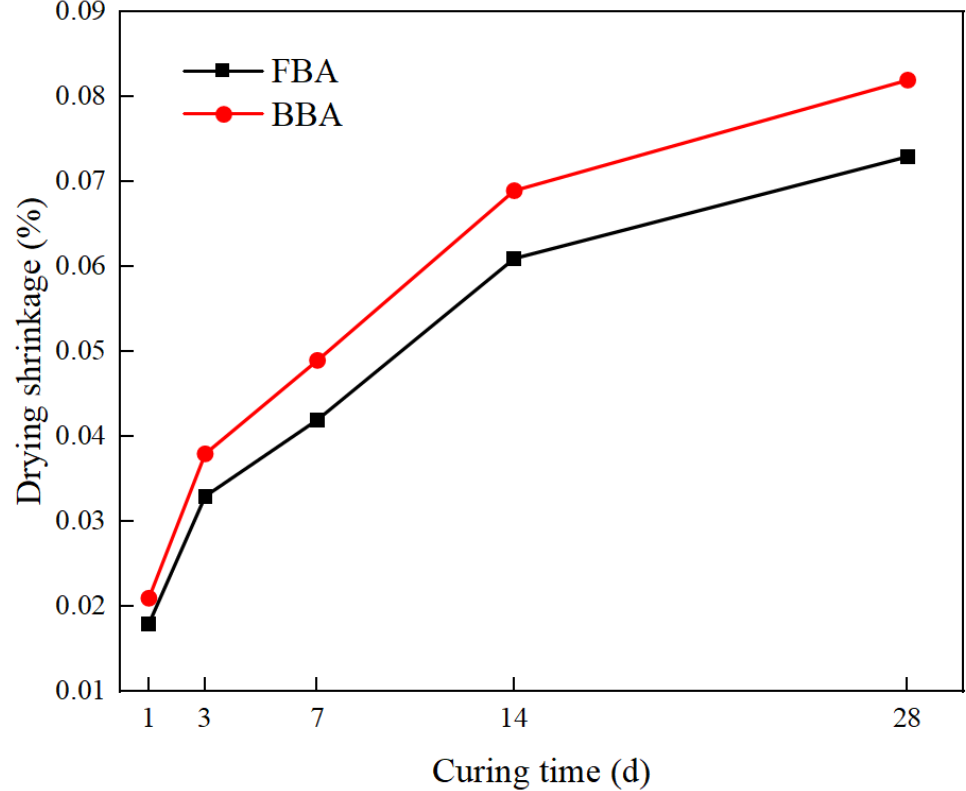
Figure 11. The effect of BA type on the drying shrinkage of MPC mortar (group 20 BA ‐ 80 MPC).